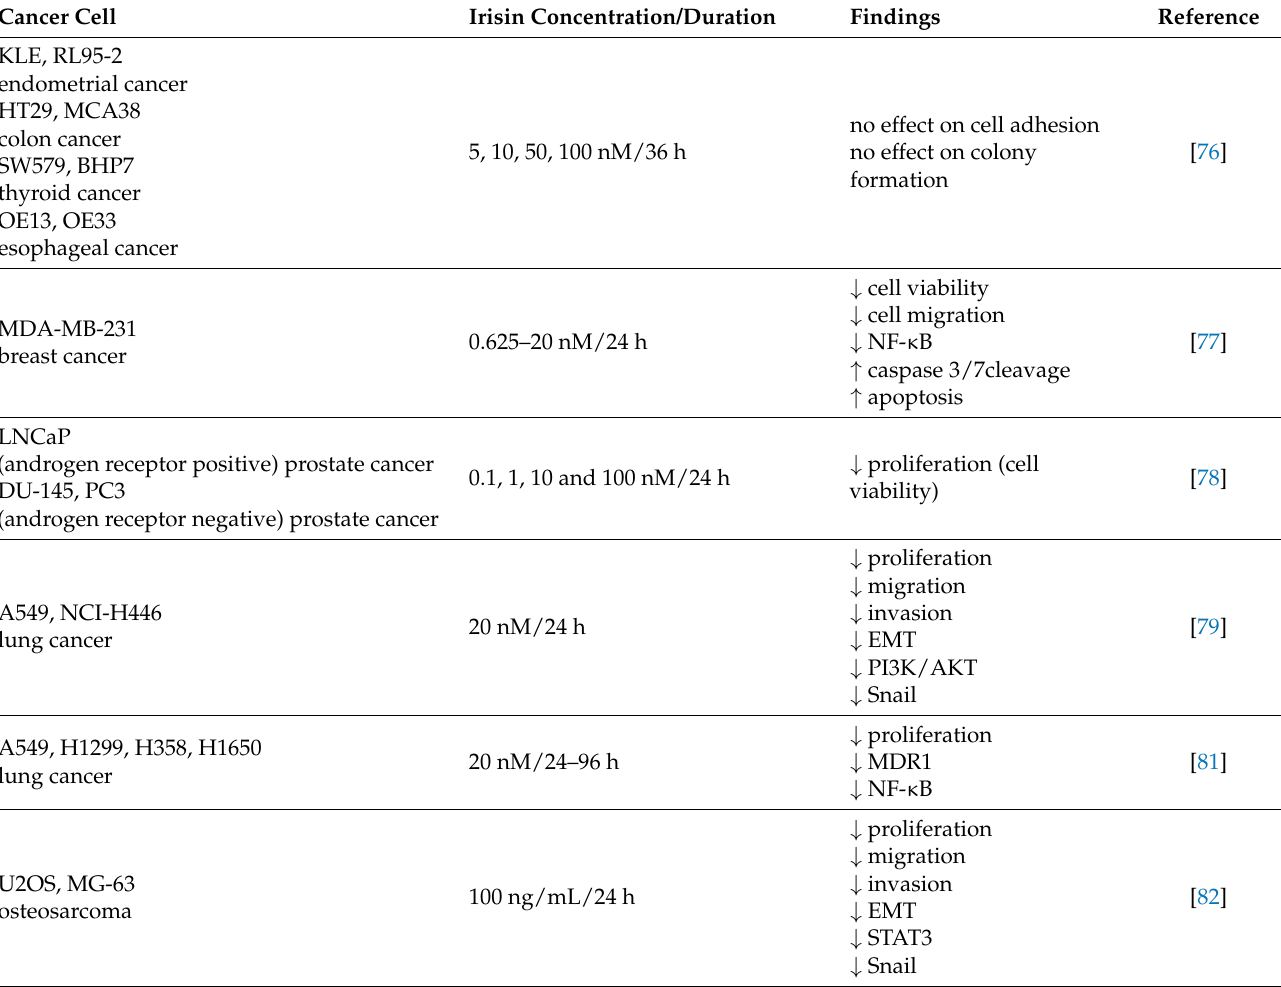
Table 1. Role of irisin in cancer: in vitro